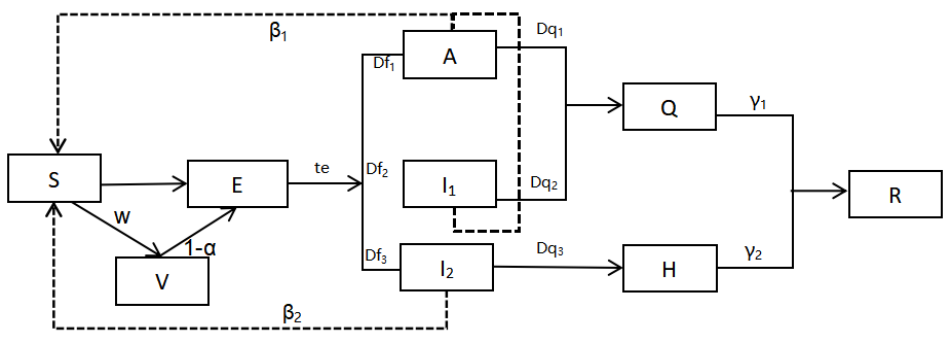
Figure 1. The structure of the SVEAI i QHR model of